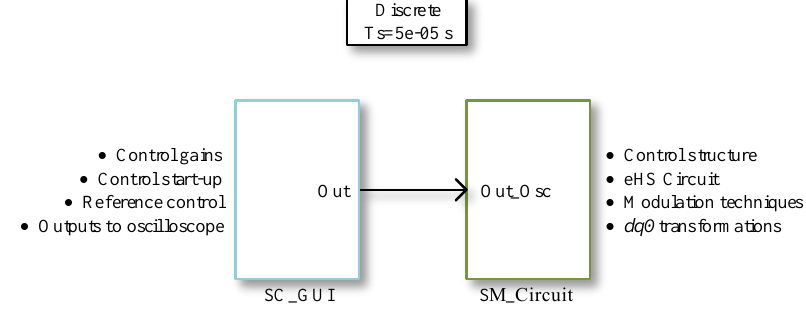
Figure 4. Circuit structure for real-time